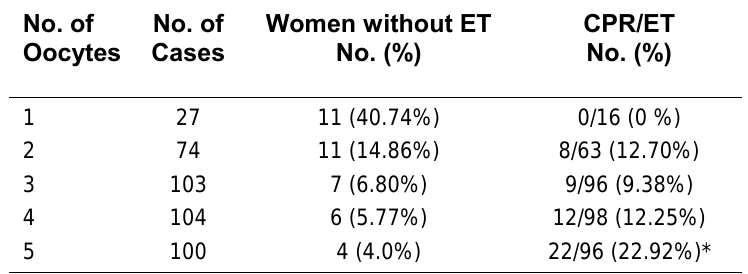
Pregnancy Rates in Low-Responding Women (Group II: 1–5